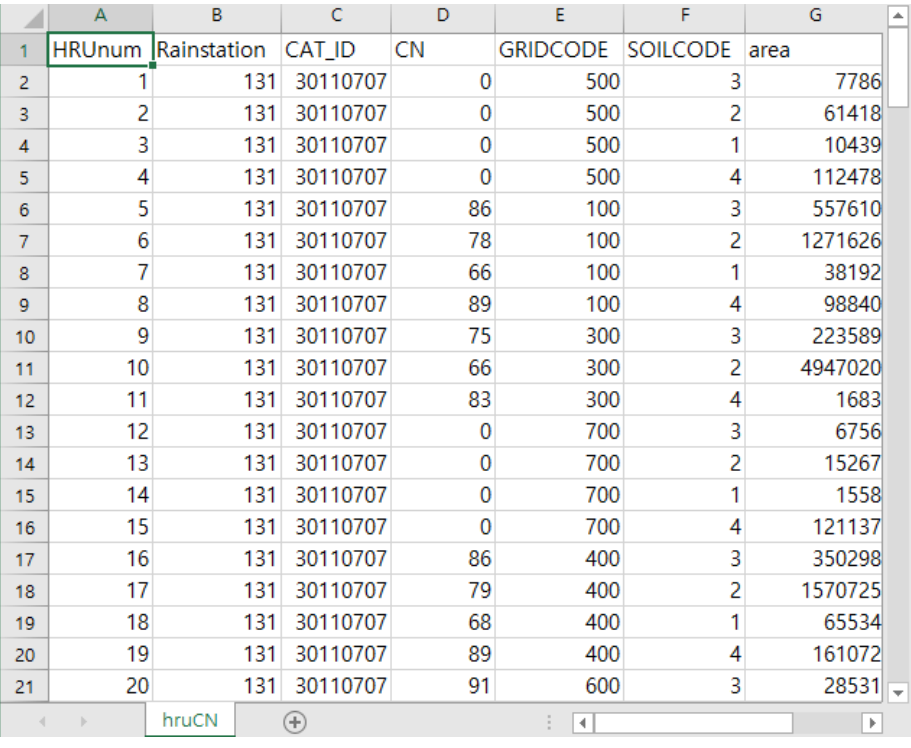
Figure 1. Schematic illustration of HRU information file.